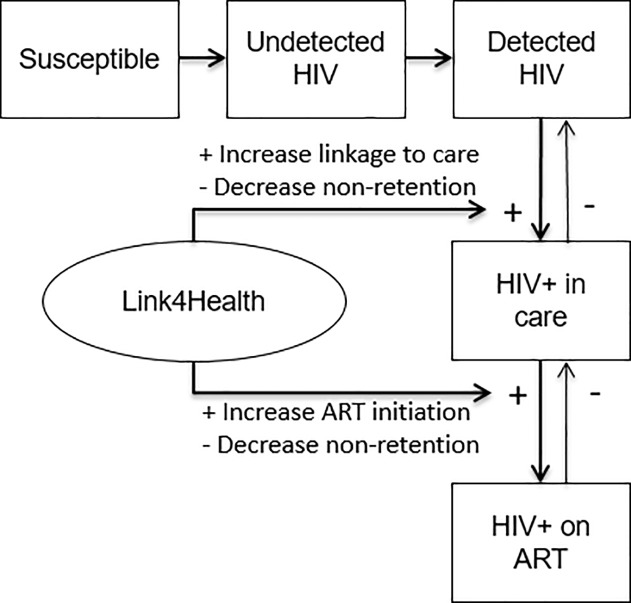
Link4Health impact on model pathways.